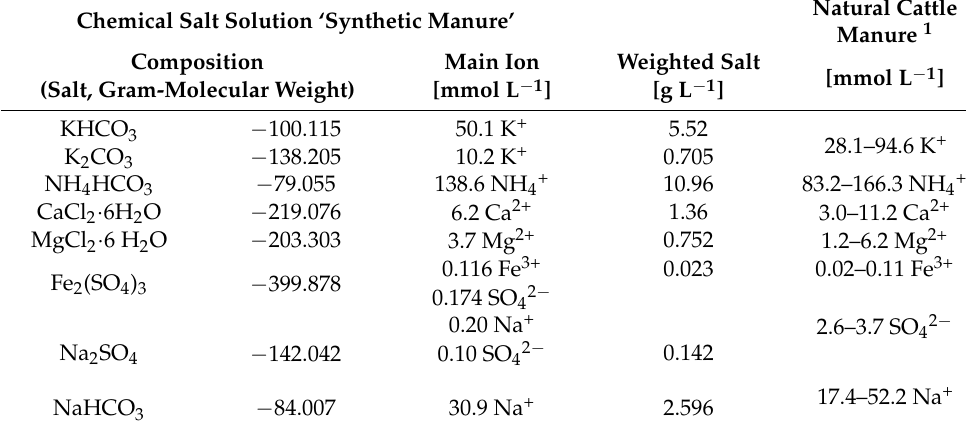
Table 2. Chemical composition of the mineral solution used as manure substitute and designated as ‘synthetic manure’